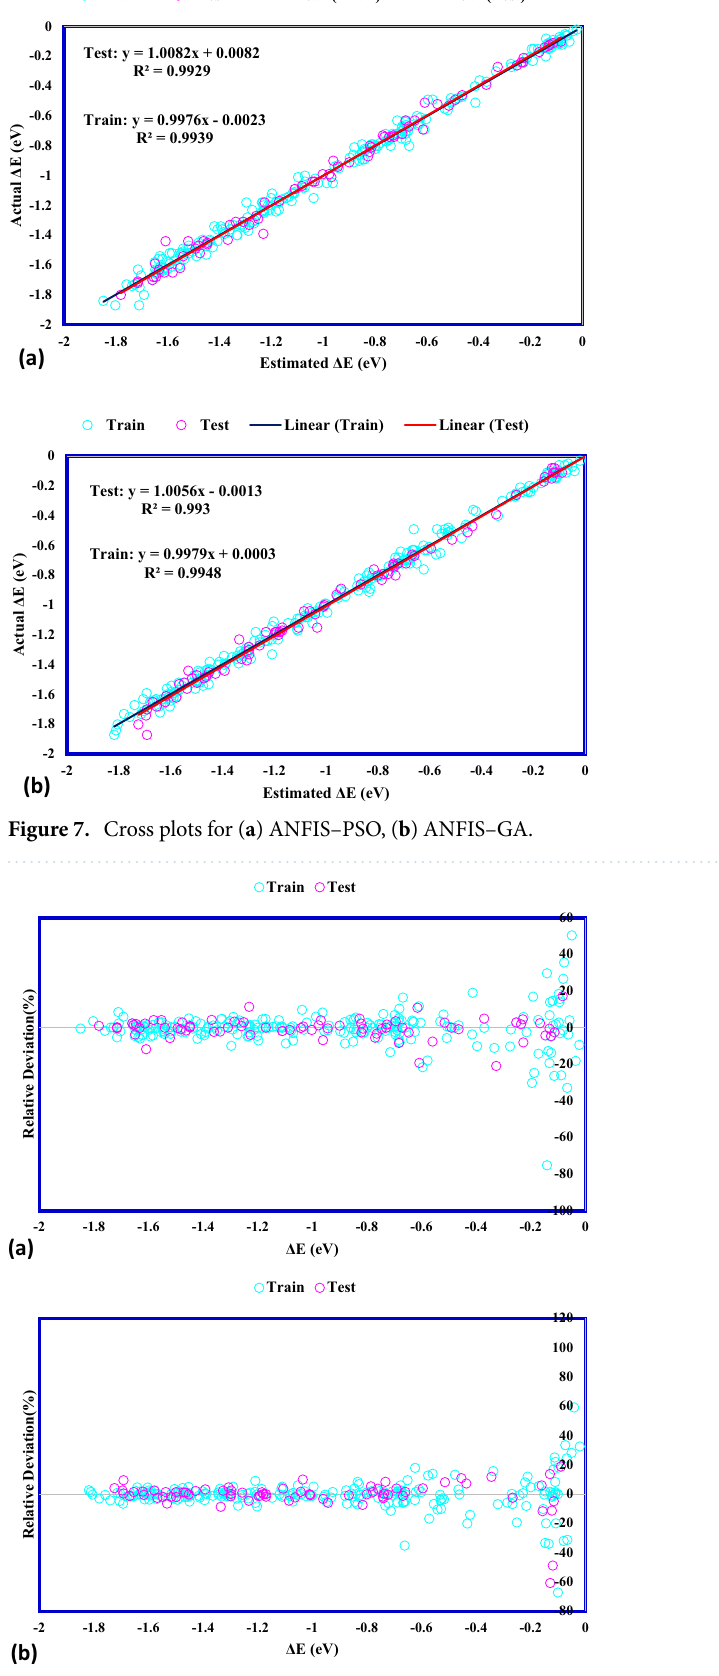
Figure 8. Comparison of experimental values and model outputs for ( a ) ANFIS–PSO, ( b )